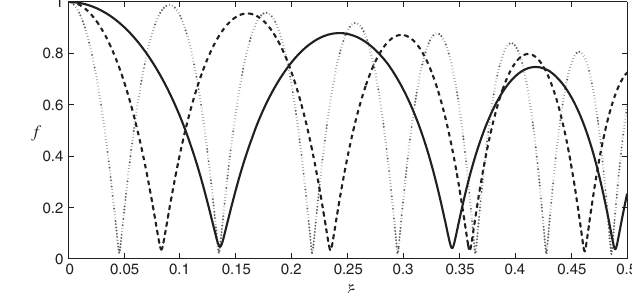
FIG. 2. Comparing the dimensionless beamwidth parameter for the propagation distance equal to one Rayleigh length, i.e., ξ ¼ 0 . 5 and in conditions of Fig. 1 for different density profile slopes, B ¼ 1 (dotted), B ¼ 2 (dash dotted) and B ¼ 5 (solid).